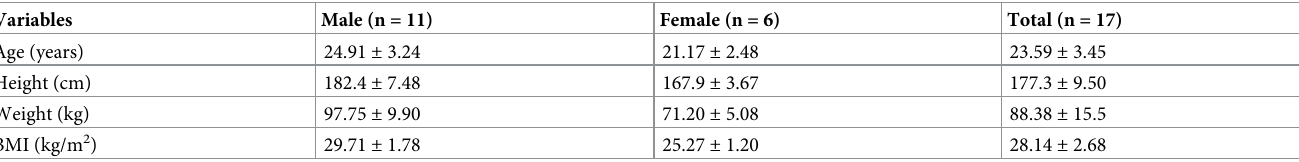
Table 1. The characteristic of the